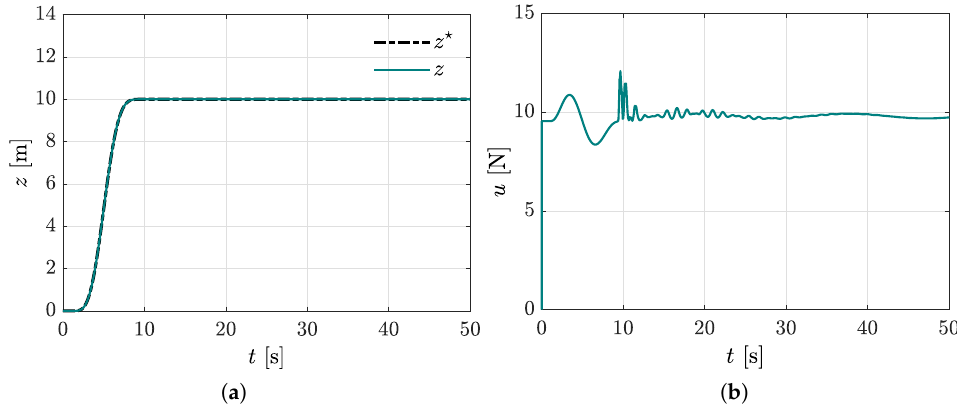
Figure 10. Controlled vertical dynamics, case 2.1. ( a ) Tracking using the vibration absorber without disturbances. ( b ) Main u force control input.